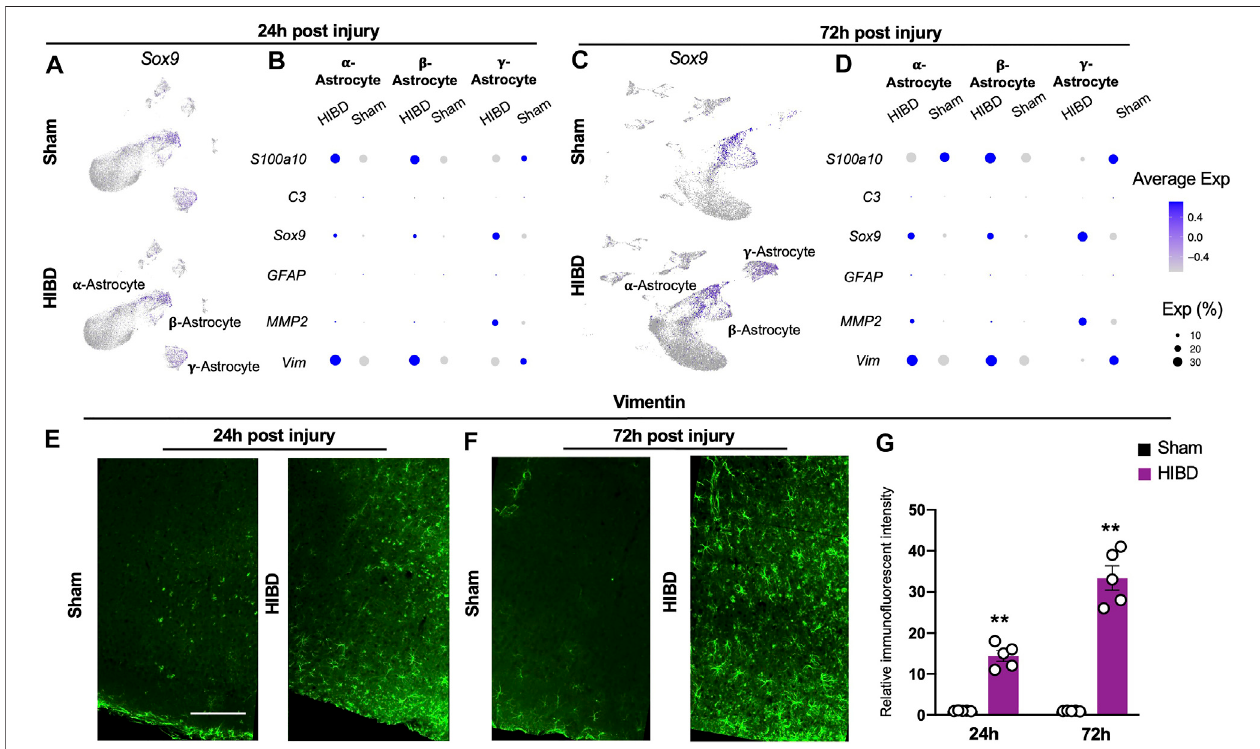
FIGURE 5 | Expression changes of characteristic genes in distinct astrocyte subtypes post neonatal HIBD (A,C) Feature plots of an astrocyte speci fi c transcriptionalfactor( Sox9 )overtotalpinealpopulationsat24 h (A) or72 h (C) postshamorneonatalHIBD,respectively (B,D )Bubbleplotsshowingexpressionlevelsof reactiveastrocyterelatedgenesat24 h (B) or72 h (D) postshamorneonatalHIBD,respectively.Note,thesizeofdotsrepresentstheabundanceofcellsexpressingofa givengene;thecolorscalerepresentsnormalized expressionlevelforagivengeneacrossallcells (E – G) Representativeimagesoftransversesectionsofthepineal gland with immunostaining against Vimentin and quanti fi cation (G) at 24 h (E) or 72 h (F) post sham or neonatal HIBD, respectively. Scale bar: 200 μ m n = 5,5 for sham and HIBD animals, fi ve sections crossing the pineal gland were used for individual animals, Student ’ s t test, **, p < 0.01.